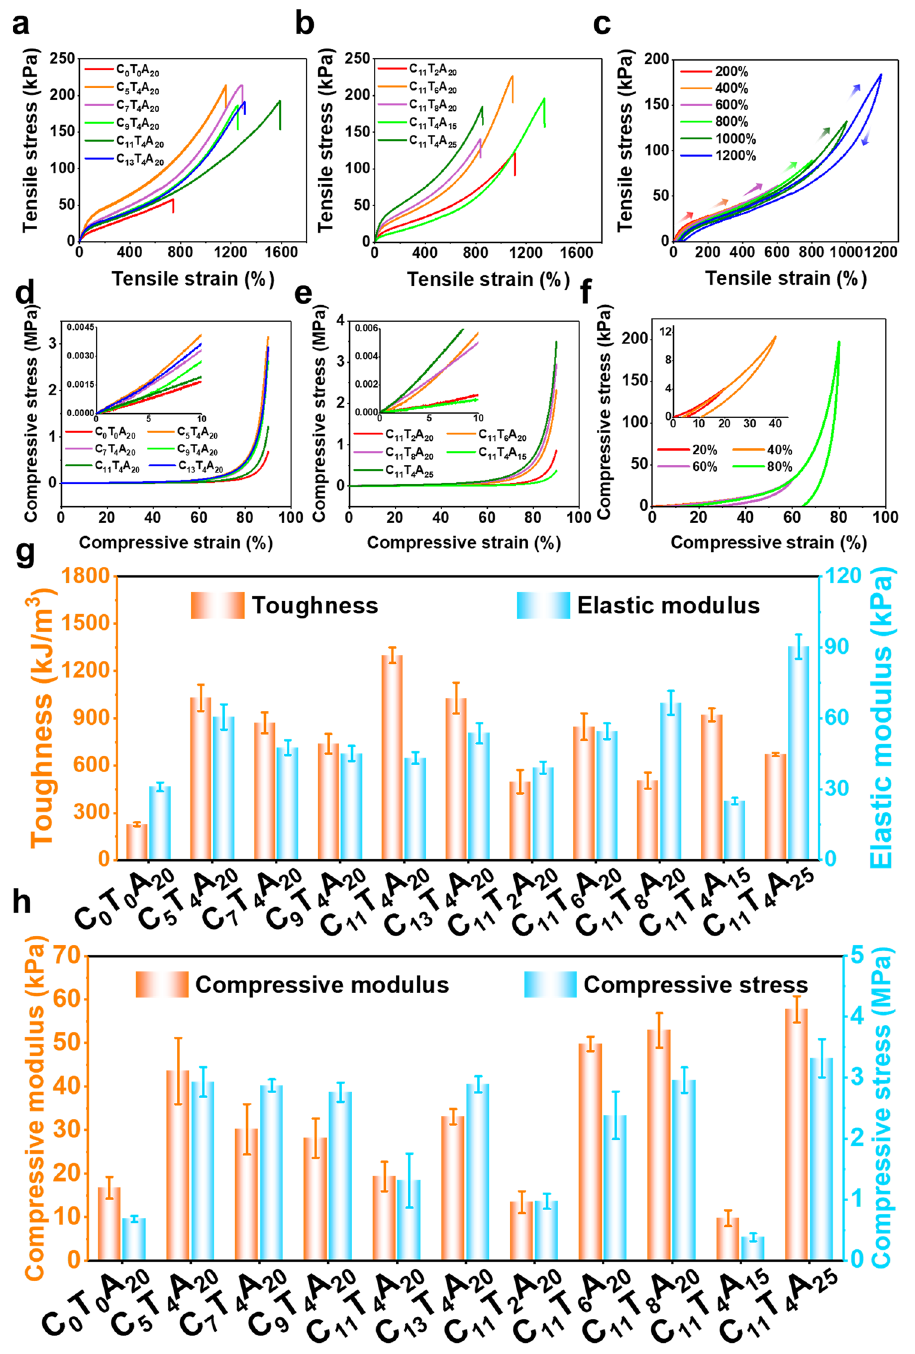
Fig. 3 Tensile stress–strain curves of CTA hydrogels with different: a molar ratio of AAm to glucose units and b mass fraction of CECT and AAm. c Representative cyclic tensile stress–strain curves of C 11 T 4 A 20 in various strains ranging from 200 to 1200%. Compressive stress–strain curves of CTA hydrogels with different: d molar ratio of AAm to glucose units and e mass fraction of CECT and AAm. The insets present the results over an initial narrow strain range. f Representative cyclic compressive stress–strain curves of C 11 T 4 A 15 in various strains ranging from 20 to 80%. g Tension and h compression properties of CTA